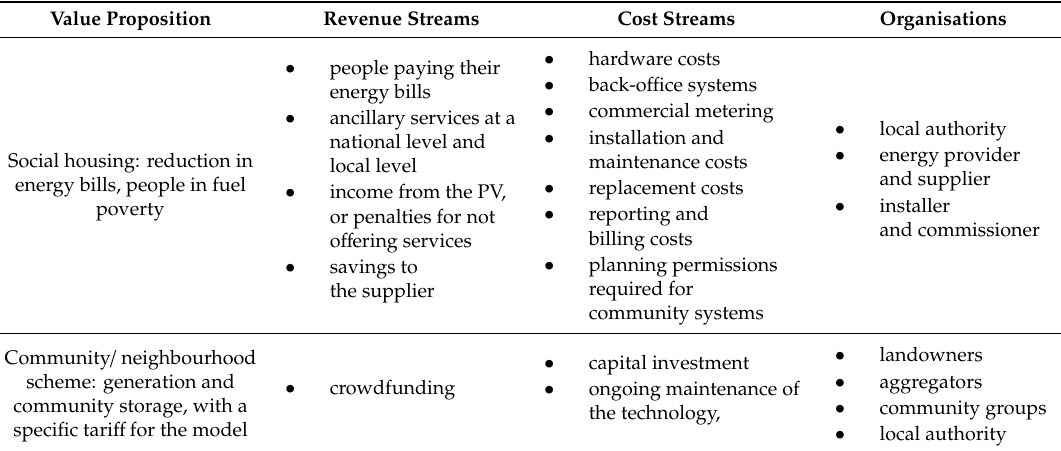
Table 1. Summary of results for the business case